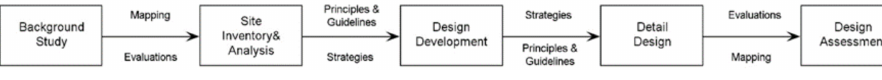
Figure 2. Stages of the approaches/design